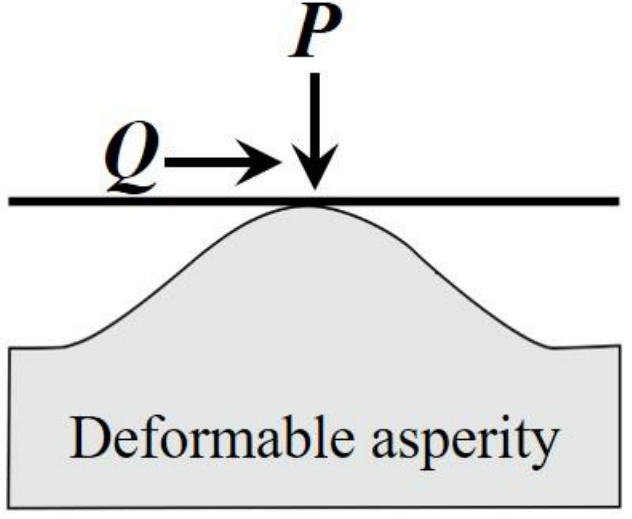
Figure 9. A deformable asperity in contact with a rigid flat surface under combined normal and tangential loading.